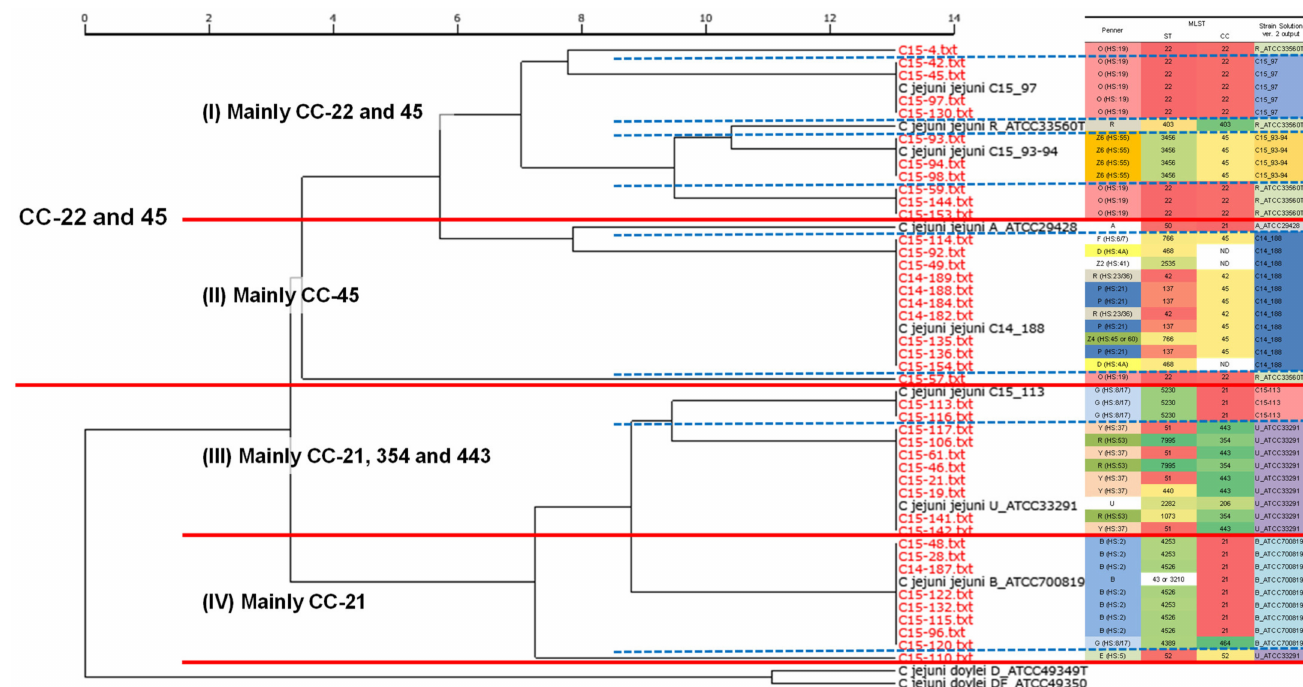
Figure 1. Cluster analysis with the result of Strain Solution ver. 2. The mass data were scanned with Strain Solution ver. 2 with the registered protein markers shown in Table 3. The clustering tree